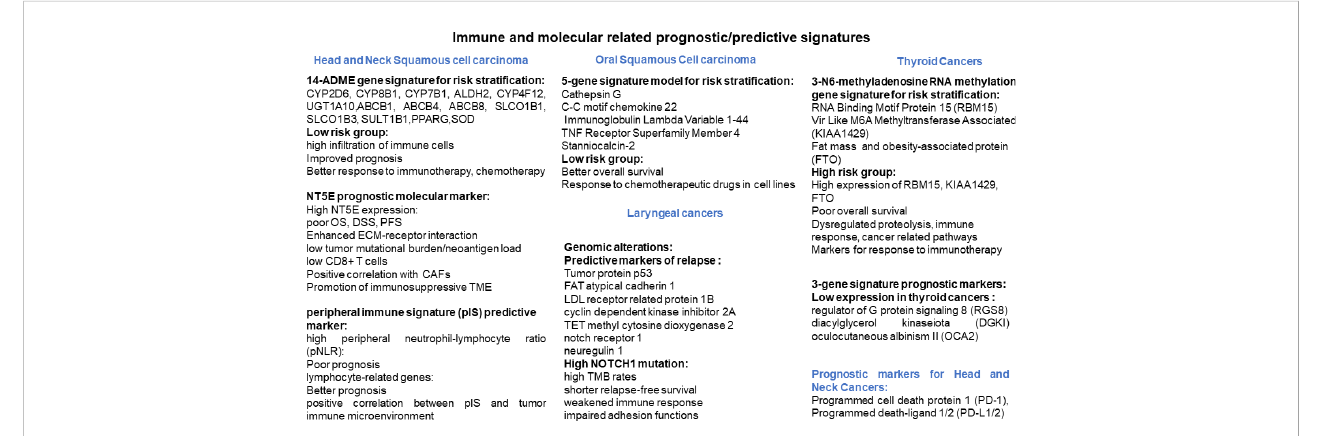
FIGURE 1 Schematic diagram showing signature biomarkers for Head and Neck